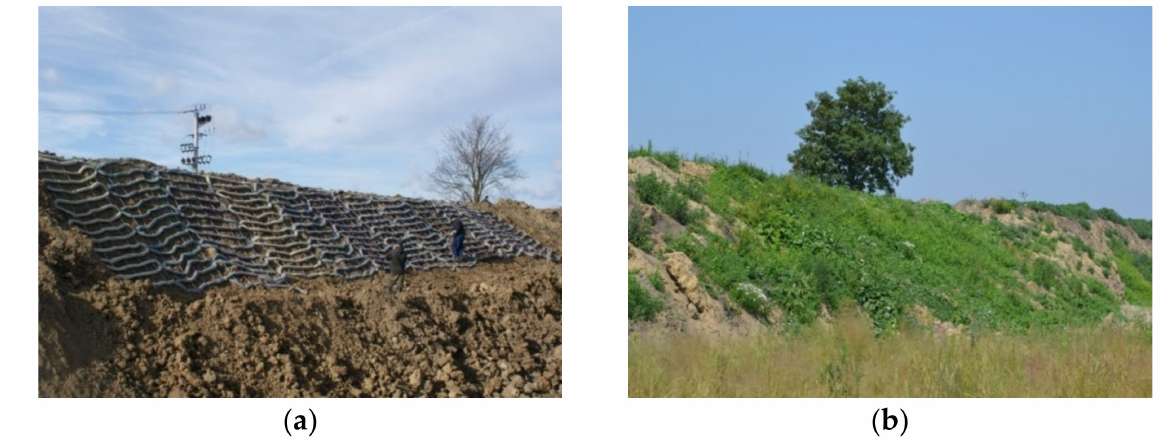
Figure 1. The effectiveness of geotextile ropes as an anti-erosion measure: ( a ) Slope state on 9 February 2016; ( b ) slope state on 23 June 2016 [17].